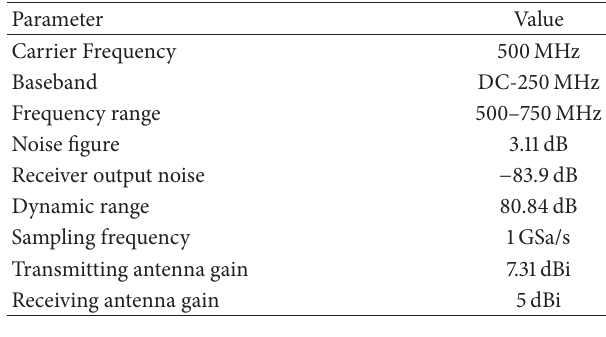
Table 1: System parameters. Table 2: Design system specifications.